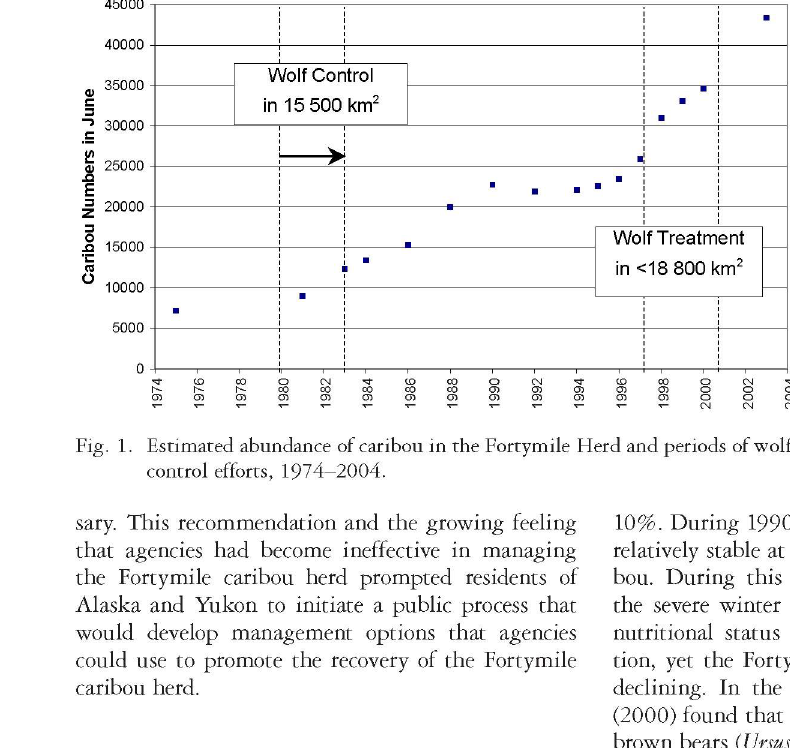
Fig. 1. Estimated abundance of caribou in the Fortymile Herd and periods of wolf control efforts,